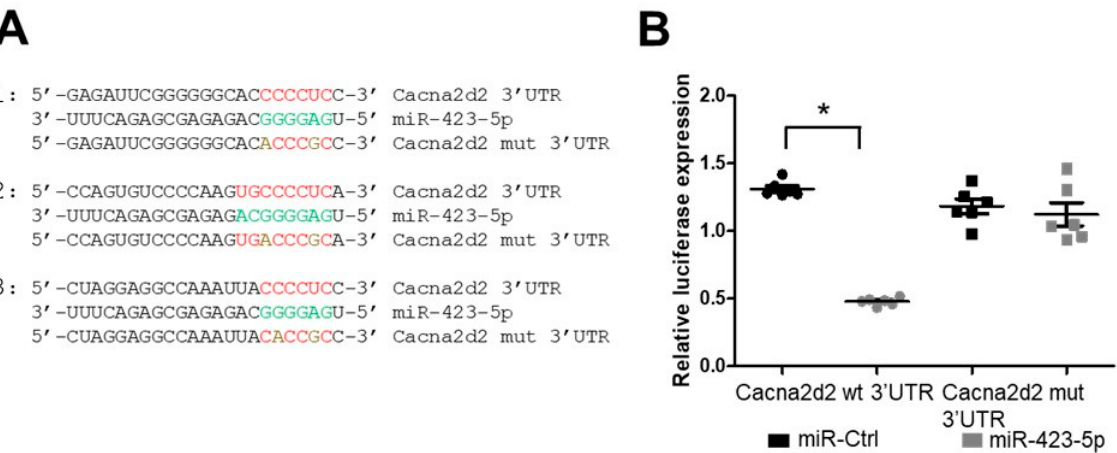
Figure 2. miR-423 has putative binding sites in Cacna2d2. ( A ) In silico analysis identified 3 putative miR-423-5p binding sites in the Cacna2d2 3 (cid:48) UTR (site 1: 426–448; site 2: 812–834; site 3: